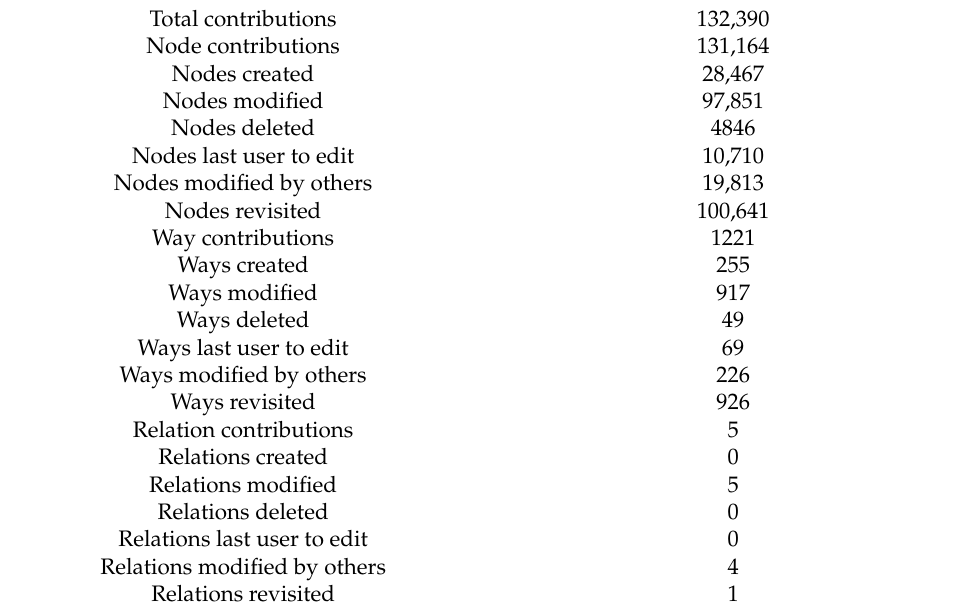
Table 4. Contributor actions attributes prepared from the Mozambique history data for user